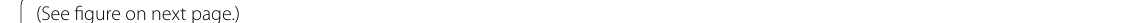
(See figure on next page.) Fig. 2 Magnetic resonance imaging findings in mucormycosis. a T1 weighted images showing hypointense polypoidal soft tissue filling bilateral ethmoids and left maxillary antrum with non-visualized left middle and inferior turbinates.T2 weighted images show b hyperintense mucosa involving bilateral maxillary sinuses with extensive inflammation in right intra- and extraconal orbital fat, c isointense soft tissue in bilateral ethmoids, d T2 fat suppressed images show hypointense mucosa in right ethmoid and nasal cavity, e Diffusion weighted images show high signal intensity in right maxillary sinus and f hypointensity in corresponding area (*) on ADC maps suggesting restricted diffusion